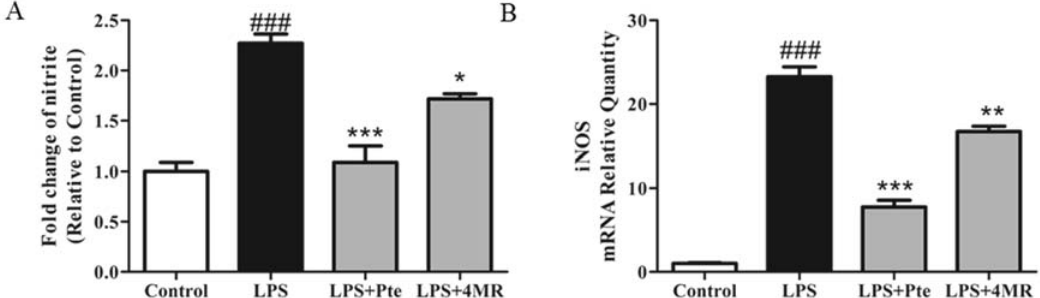
Figure 3. Effect of Pte and 4MR on lipopolysaccharide (LPS)-induced ( A ) nitrite production and ( B ) iNOS mRNA expression in RAW264.7 cells. Cells were cotreated with both LPS (0.1 µ g/mL) and Pte (5 µ M) or 4MR (5 µ M) for 24 h. The NO levels in the culture medium were determined using the nitrate reductase method. The mRNA expression levels were evaluated by qRT-PCR and normalized to the 18S levels. The data were representative of the three independent experiments and presented as the mean ± SEM. ### p < 0.001 compared to control; * p < 0.05, ** p < 0.01, and *** p < 0.001 compared to LPS alone.